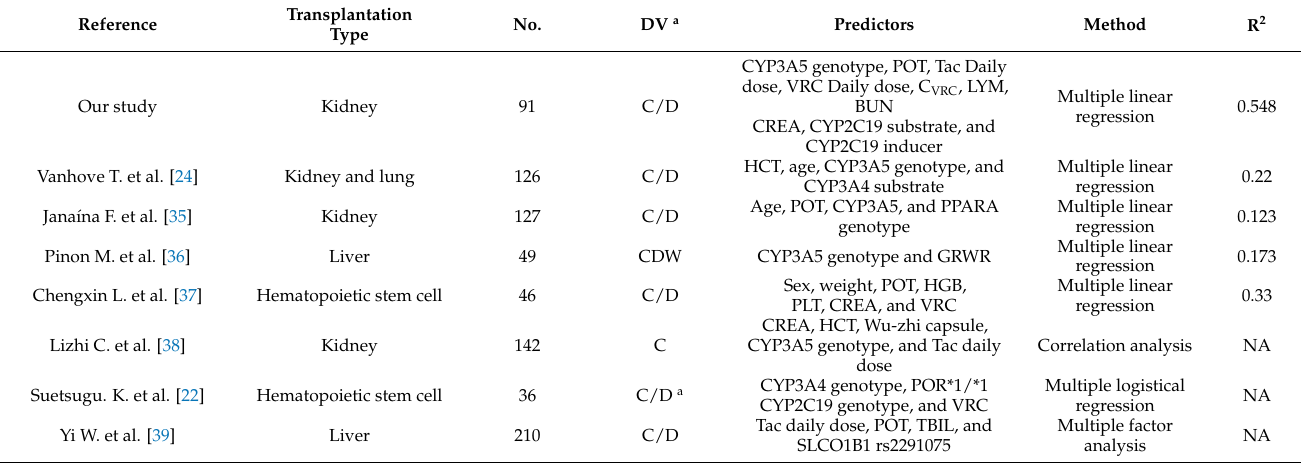
Table 7. Predictors associated with tacrolimus concentration in different